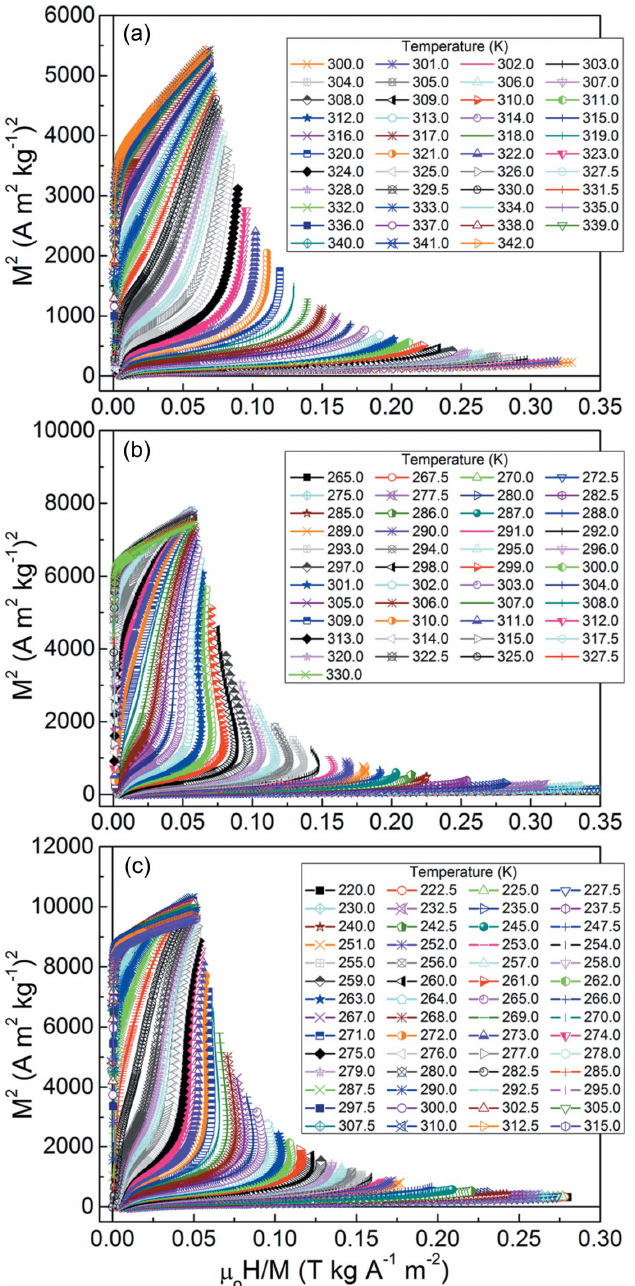
Figure 9 Arrott plots for the melt-spun ribbon samples. ( a ) Mn 50 Ni 36 Co 6 Sn 8 , ( b )